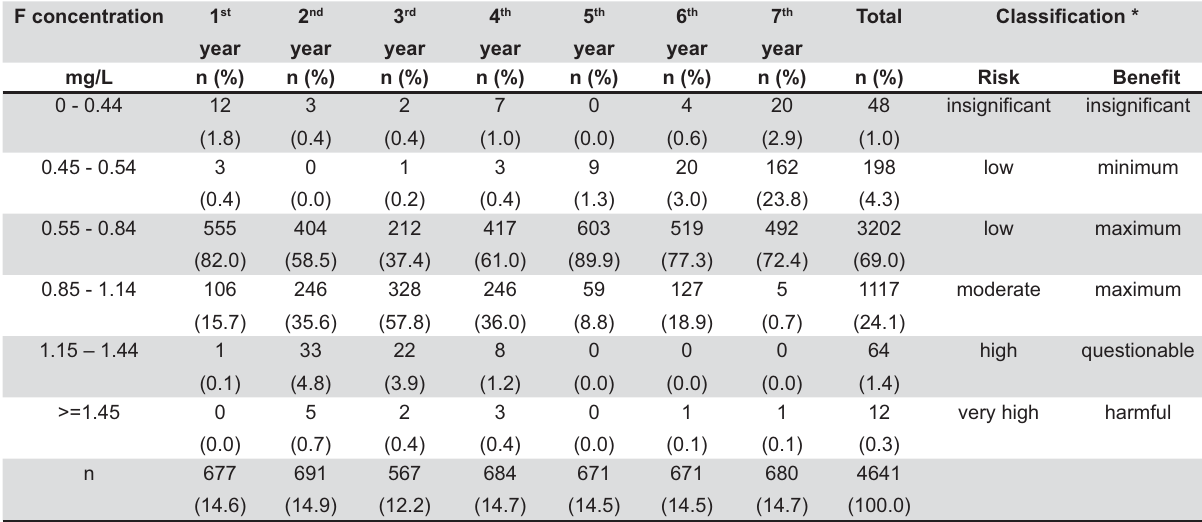
* According to CECOL/USP 6 ,